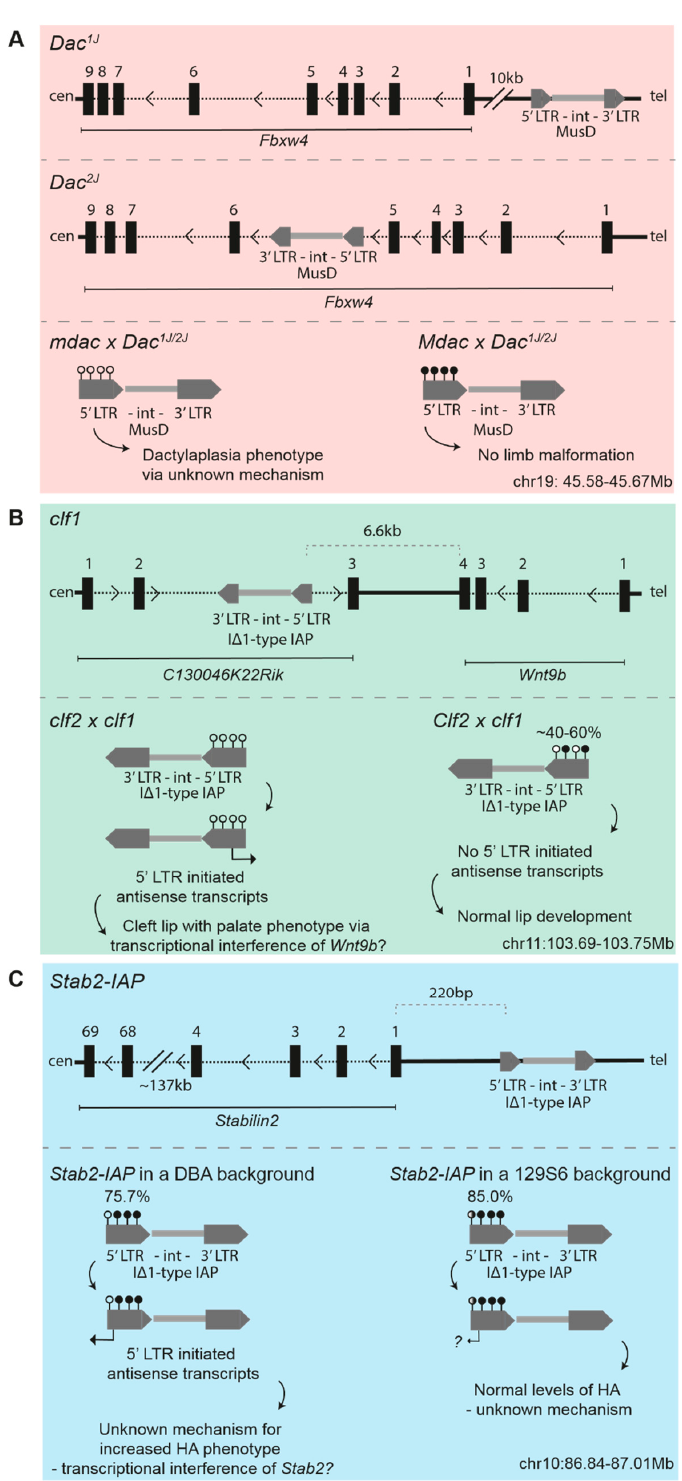
Figure 1. Schematics for the insertion sites of endogenous retroviruses (ERVs) subject to strain-specific regulation (upper panel) and the effects of strain-specific modifier activity (lower panel) for ( A ) Dac 1j and Dac 2j , ( B ) clf1 , and ( C ) Stab2-IAP . Sticks with closed circles represent methylated CpGs in the long terminal repeat (LTR) of the ERV; sticks with open circles represent unmethylated CpGs. Black dotted lines depict introns; thick black lines depict intergenic regions. The information is based on the latest patch release of the 2011 mouse assembly on the UCSC Genome Browser (GRCm38.p6); the coordinates given are mm10.